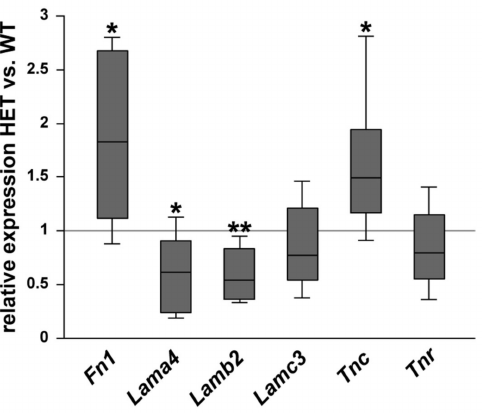
Figure 4. Diminished glycoprotein expression in the glaucomatous optic nerve of HET animals. Comparison of ECM glycoprotein expression in optic nerves of WT and HET mice was revealed by RT-qPCR analyses. Significantly higher Fn1 and Tnc expression levels were observed in the optic nerves of HET compared to WT mice. Comparable mRNA levels were found for Tnr and Lamc3 . In contrast, the expression of Lama4 and Lamb2 was significantly downregulated in the optic nerves of HET compared to WT mice. Groups were compared using a pairwise fixed reallocation and randomization test. Data are shown as median ± quartile ± minimum/maximum. * p < 0.05, ** p < 0.01. n = 5/group.